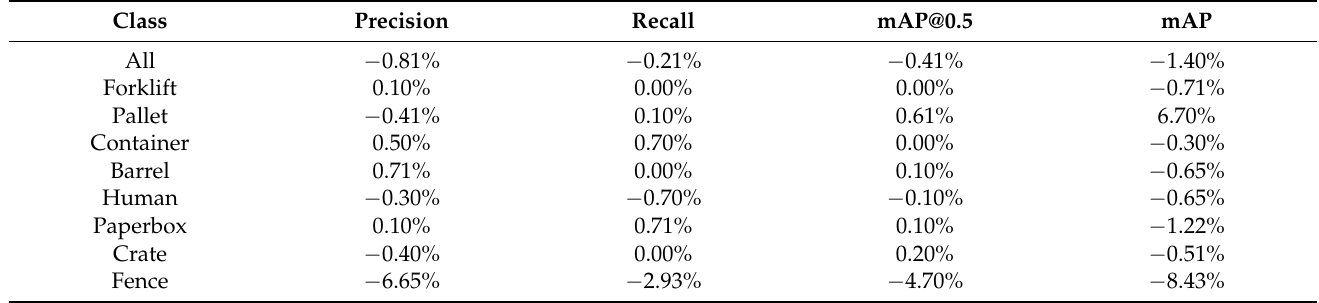
Table 1. Results from the small model displayed as the difference in percentage from the xlarge model.